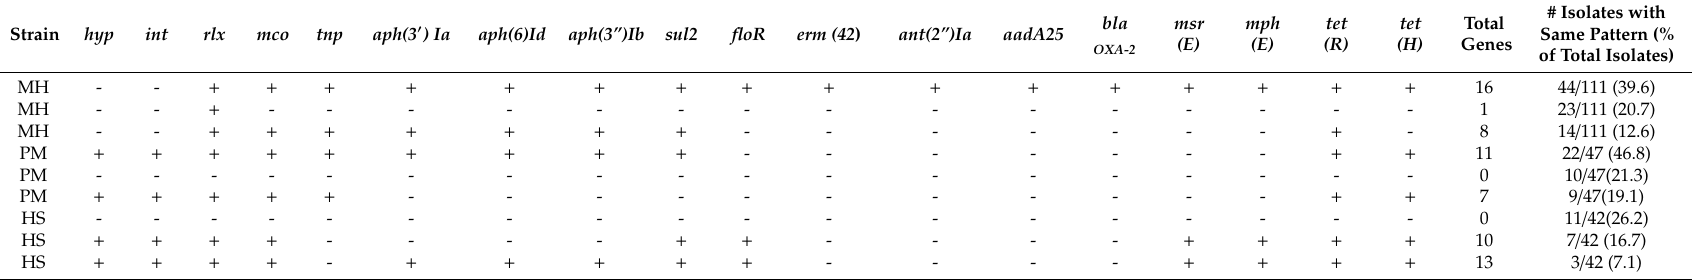
Table 4. The three most common AMR gene PCR patterns z for M. haemolytica (MH), P. multocida (PM) and H. somni (HS) isolated from lung tissue of bovine respiratory disease mortalities. ‘ + ’ = present, ‘-’ = absent; ICE core gene fragments y ; AMR gene fragments.